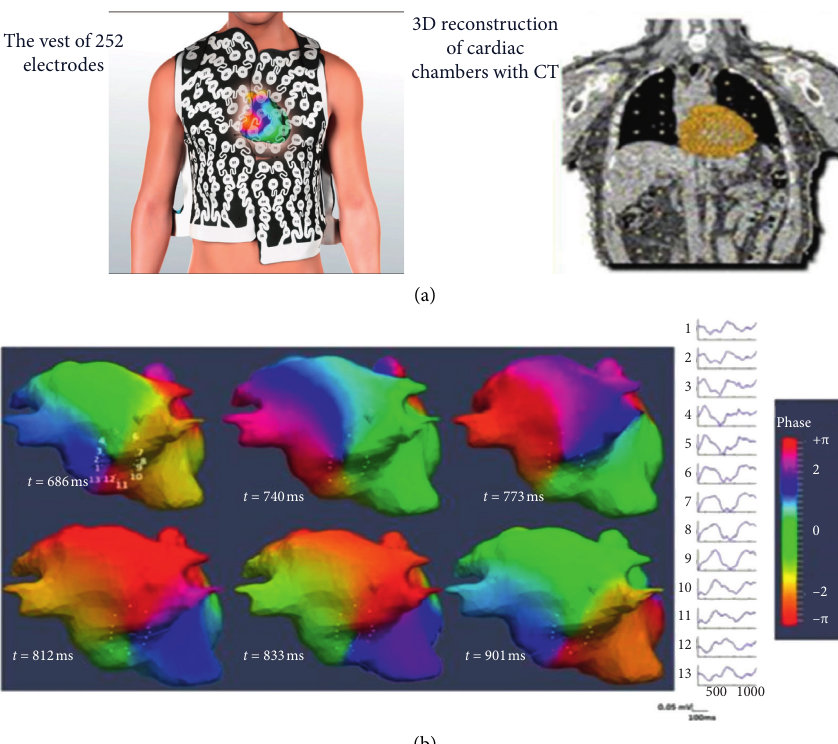
Figure 10: Noninvasive body surface mapping. (a) The vest of 252 electrodes and the three-dimensional reconstruction of cardiac chambers with the computed tomography. The voltage at each point of the torso, taken from the 252 electrodes of the vest, is depicted with virtual electrograms on the surface of the atria. (b) Isochronous maps showing the rotational activity near the antrum of the right inferior